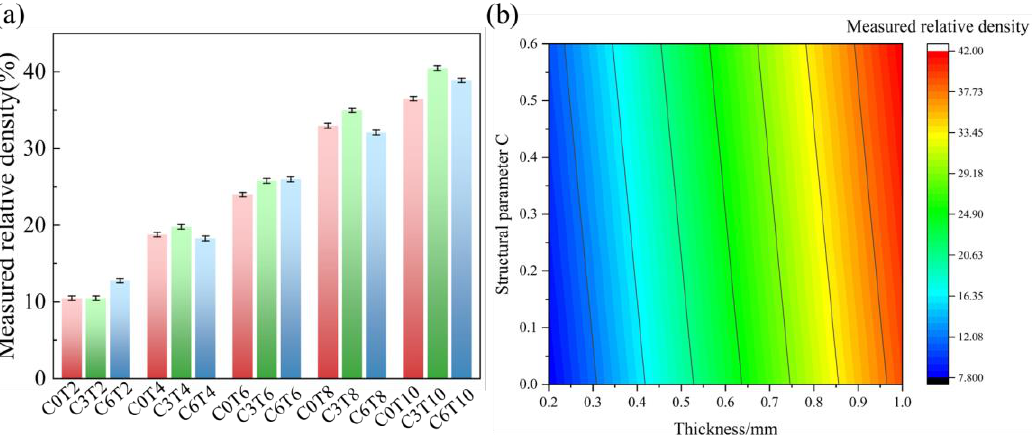
Figure 4. ( a ) The relative density of as-built P-TPMS. ( b ) The predicted value of relative density under different structural parameters.